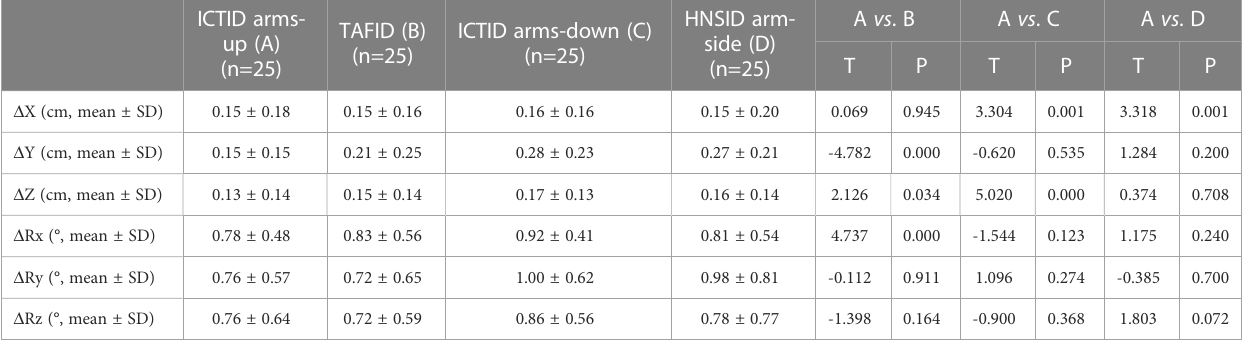
TABLE 2 Overall setup errors for the four immobilization methods.